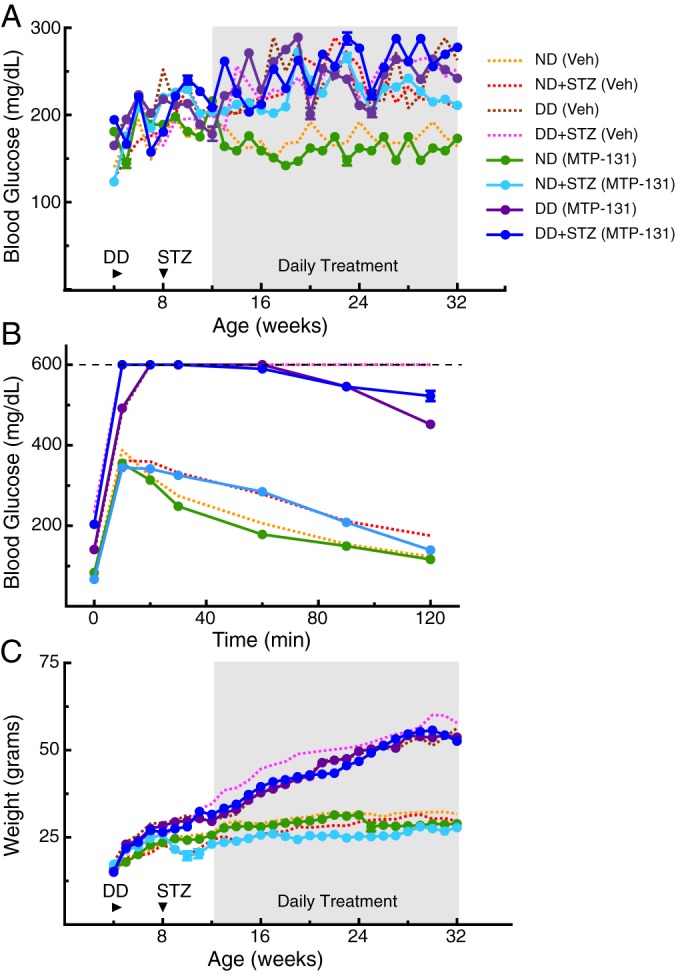
Metabolic dysfunction was not improved by daily systemic treatment with MTP-131. Daily MTP-131 treatment is indicated by shading. Dotted lines are traces from Fig. 1, depicting the effect of Veh treatment. (A) MTP-131 treatment did not reduce resting fed blood glucose in any of the experimental groups. (B) MTP-131 had no effect on glucose clearance at 32 weeks in any experimental group. (C) MTP-131 did not mitigate weight gain in the groups fed a DD.